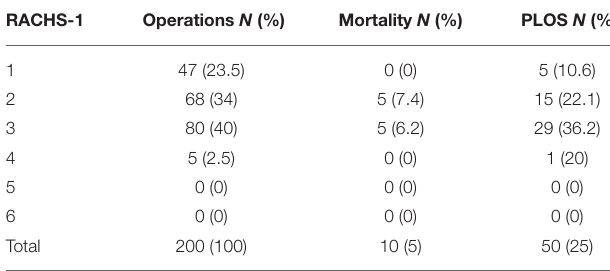
TABLE 2 | Distribution of cases operated in Croatia by complexity level, mortality, and prolonged length of stay (PLOS), expressed in RACHS-1 category classification (2003–2007).